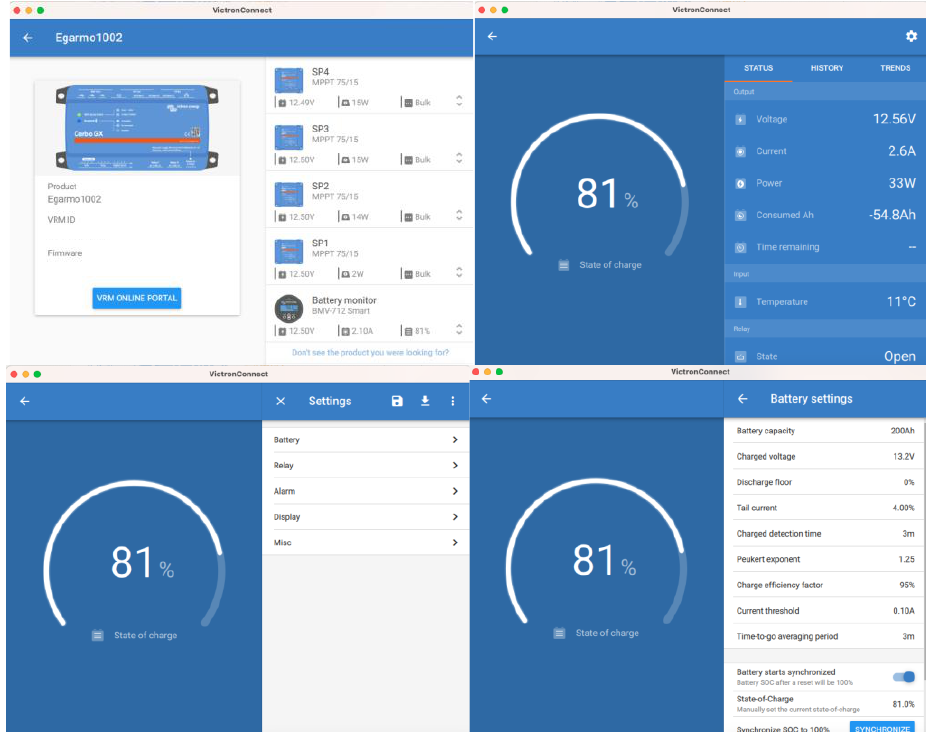
Figure 19. Optional user synchronization to 100% SOC.